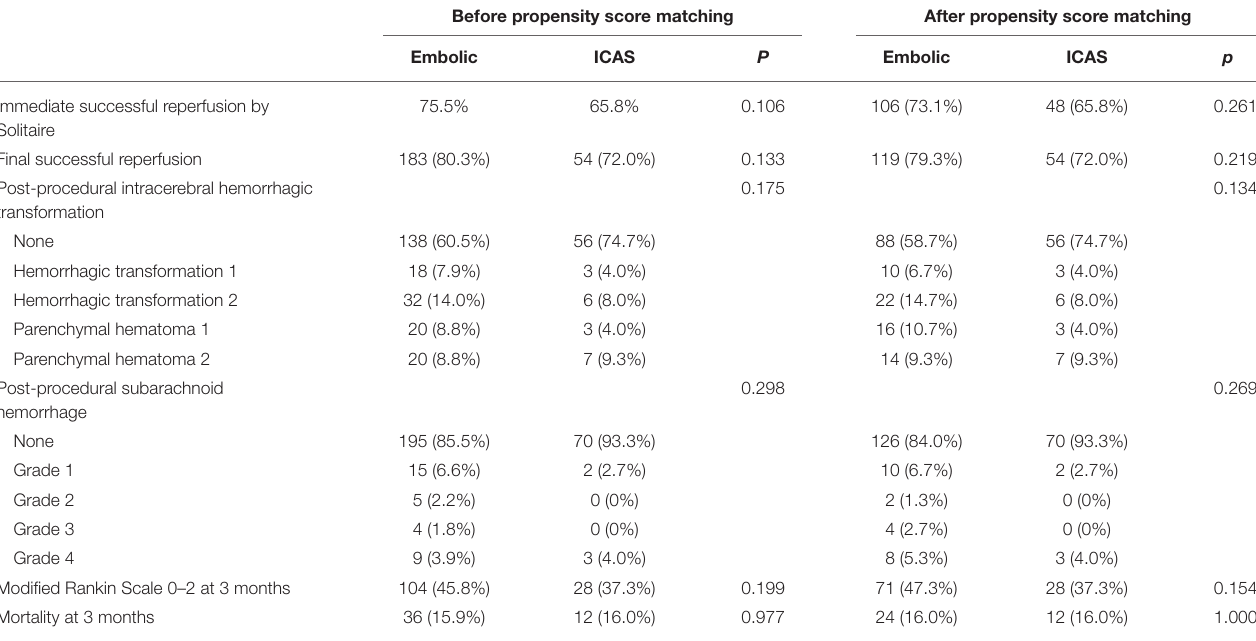
TABLE 2 | Revascularization